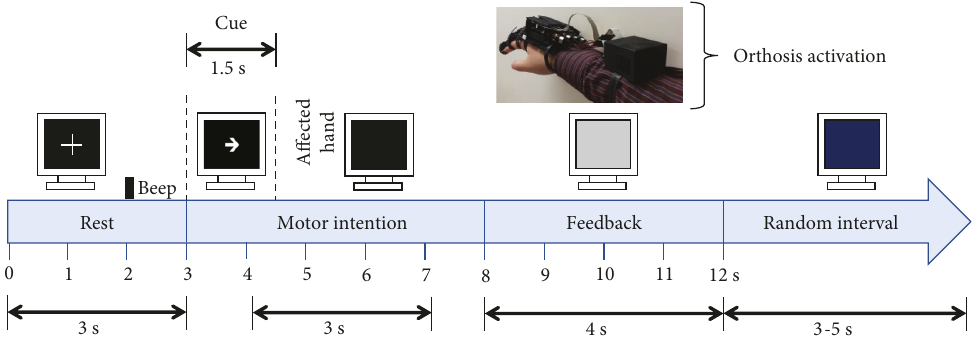
Figure 2: Structure of trials during the BCI